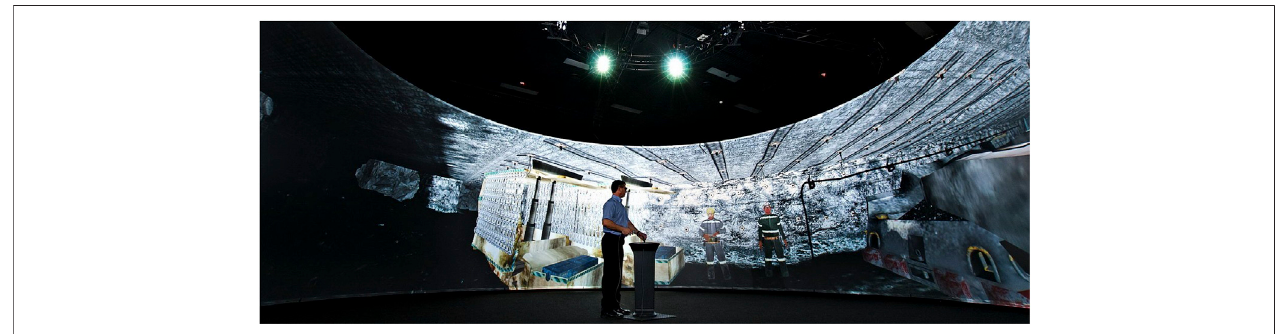
FIGURE 1 | The 360 ° immersive theater (360-VR) in